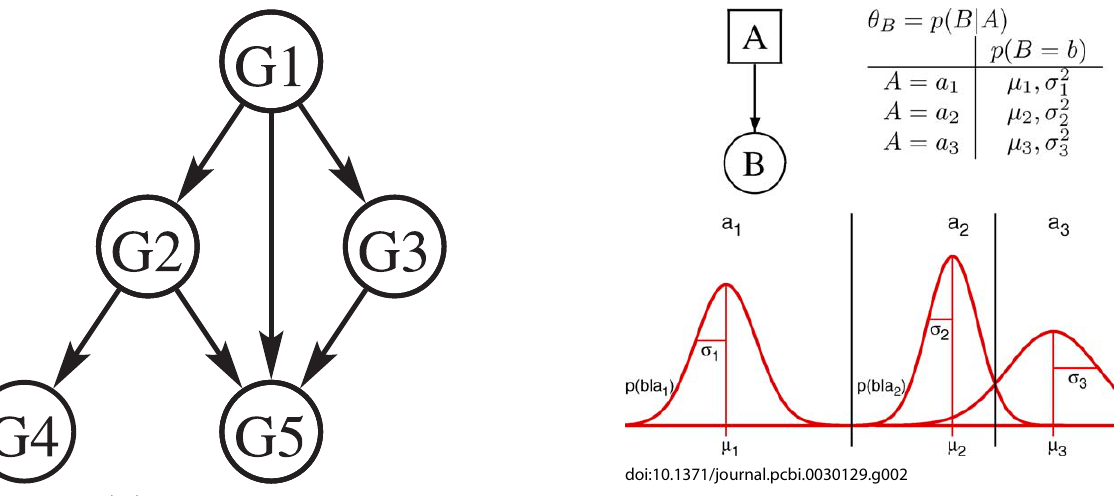
doi:10.1371/journal.pcbi.0030129.g001 Figure 1. An Example: Gene Regulatory Networks Gene regulatory networks provide a natural example for BN application. Genes correspond to nodes in the network, and regulatory relationships between genes are shown by directed edges. In the simple example above, gene G1 regulates G2, G3, and G5, gene G2 regulates G4 and G5, and gene G3 regulates G5. The probability distribution for the expression levels of each gene is modelled by the BN parameters. Simplification results from the fact that the probability distribution for a gene depends only on its regulators (parents) in the network. For instance, the expression levels of G4 and G5 are related only because they share a common regulator G2. In mathematical terms, they are conditionally independent given G2. Such relationships lead to factorisation of the full JPD into component conditional distributions, where each variable depends only on its parents in the network. p (G1, G2, G3, G4, G5) ¼ p (G1) p (G2 j G1) p (G3 j G1) p (G4 j G2) p (G5 j G1, G2,